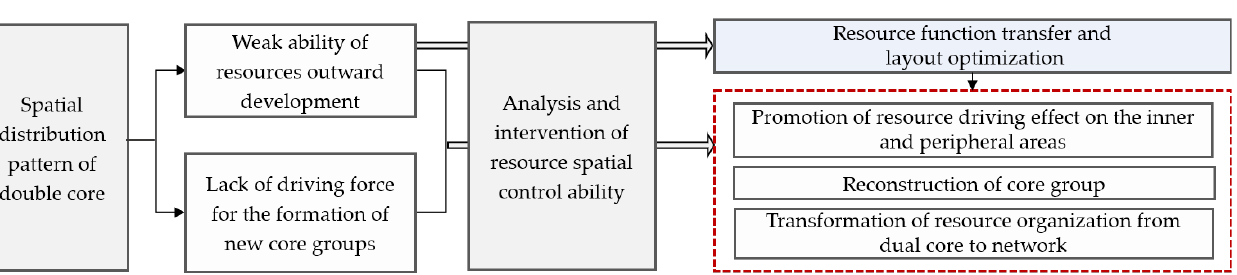
Figure 11. Analysis on the development of core elements in the network structure of Ning’an.